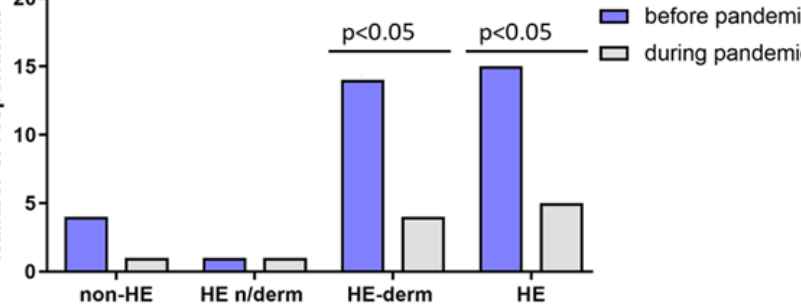
Figure 23. Comparison of the prevalence of skin infections in the study before and during the pan- demic.